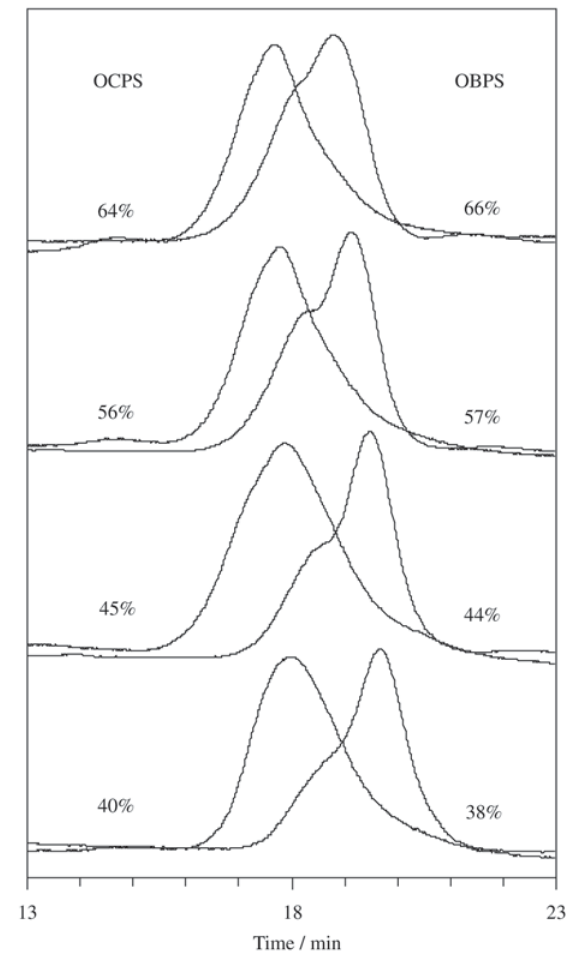
Figure 3. GPC traces of PMMA hybrids initiated by OCPS or OBPS and obtained under similar reaction conditions with approxi- mate the same monomer conversions. [initiator] = 2.92 mM, [CuCl] = 23.4 mM, MMA:initiator group (–Cl or –Br) = 100.